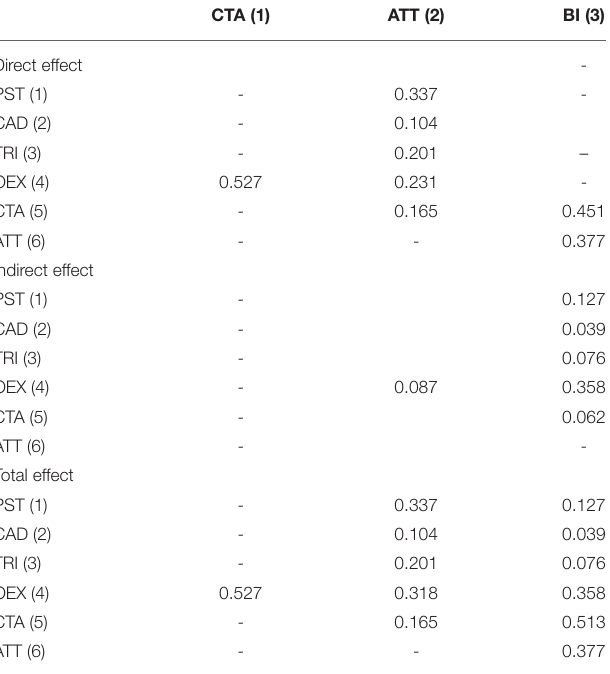
TABLE 5 | Direct, indirect, and total